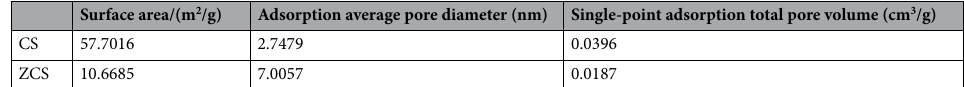
Surface area/(m 2